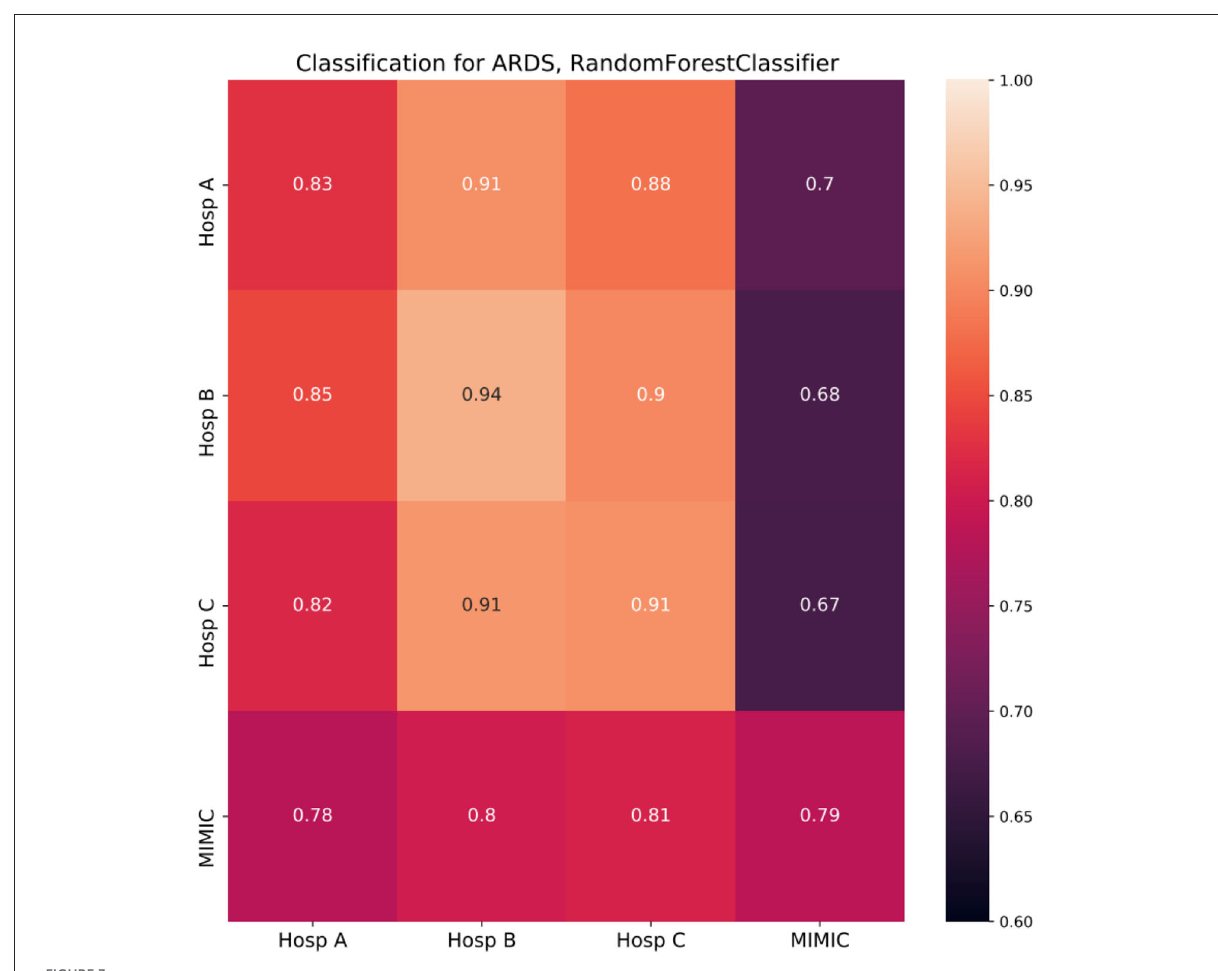
FIGURE3 Random forest classifier classification results (cross-prediction matrix) for ARDS on the first day in ICU. RF trained in each of the four hospitals (row name) and applied in each of the four hospitals (column name). Diagonal cells represent the performance of specialized models which were trained and tested in the same hospital. Non-diagonal cells represent the performance of such models once they are applied in other hospitals and reflect ability of a model to generalize to the unseen population of another hospital. Twenty-one features common for all four hospitals were used to build corresponding RF models. Performance is depicted in terms of ROC